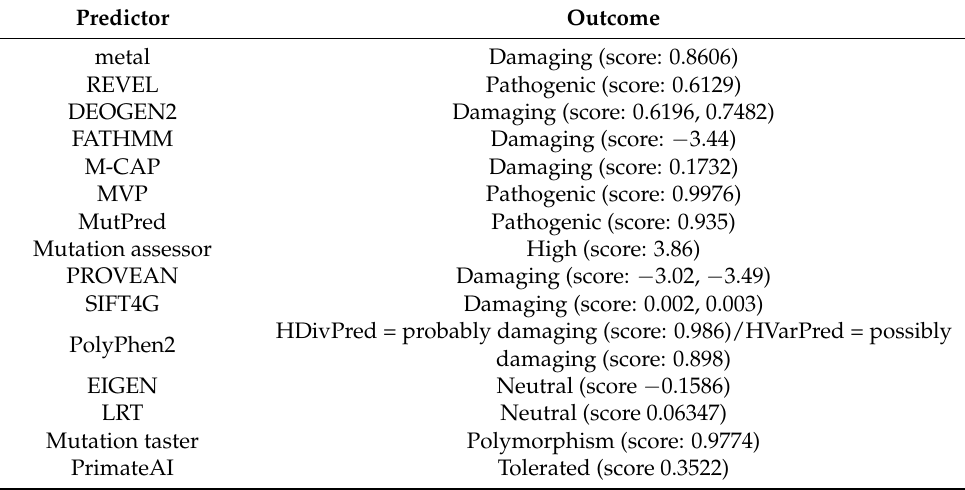
Table 3. A detailed summary of the predictors and meta predictors